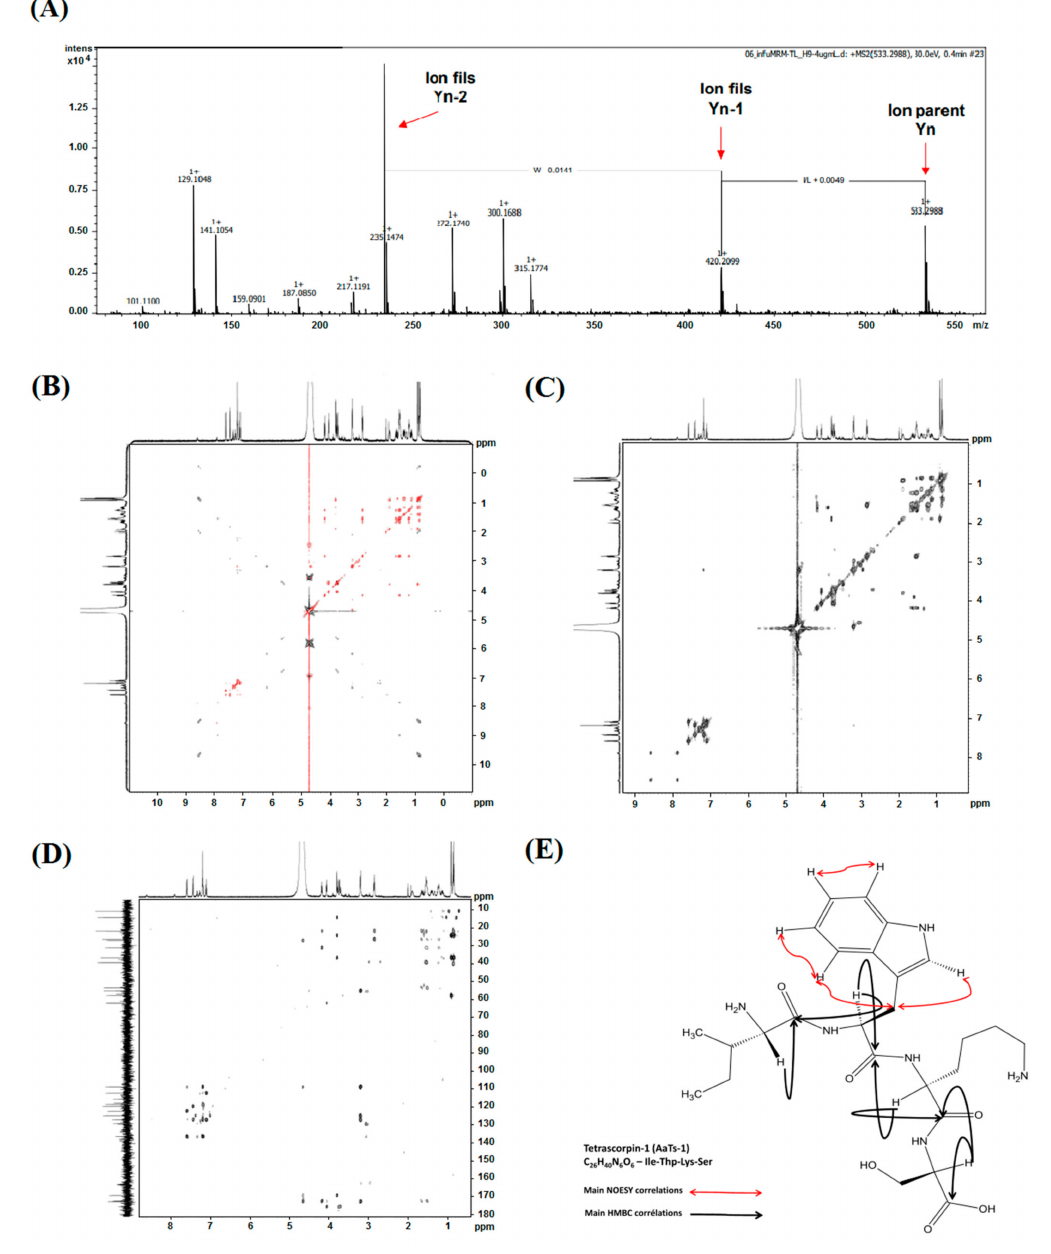
Figure 3. Structural characterization of H9. ( A ) LC-MS/MS spectrum of H9 and amino acid composition. The exact mass of H9 was determined by UHPLC-C18 connected to an ESI-Q-TOF mass spectrometer. 2D NMR spectra: ( B ) 1 H- 1 H TOCSY, ( C ) 1 H- 1 H COSY, and ( D ) 1 H- 13 C HMBC. ( E ) Main NOESY and HMBC correlations for chemical structure of